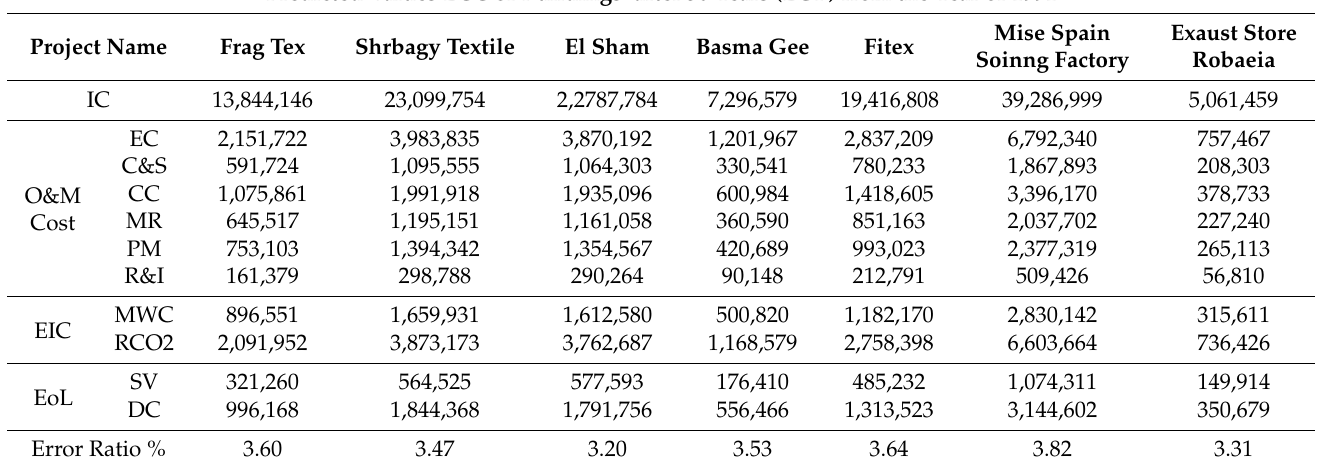
Table 6. The predicted values from the deep learning model after 30 years. Predicted Values LCC of Buildings’ after 30 Years (EGP) from the Year of 1991